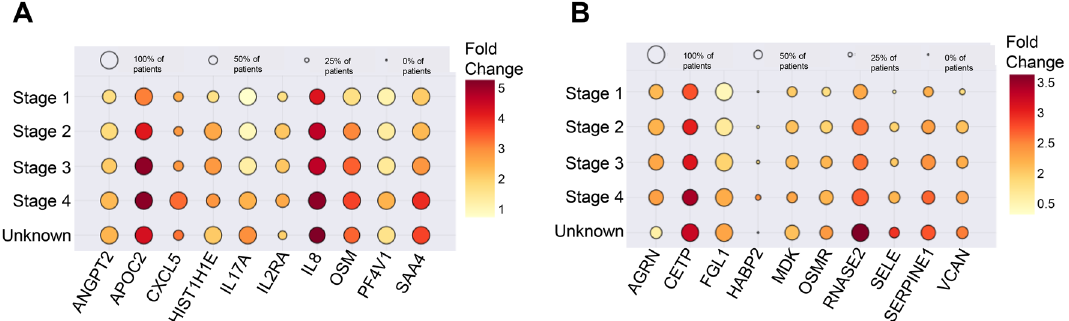
Figure 3. ( A ) Stage-wise incremental over-expressions of leading genes in patients with esophageal cancer. ( B ) Stage-wise incremental over-expressions of leading genes in patients with stomach